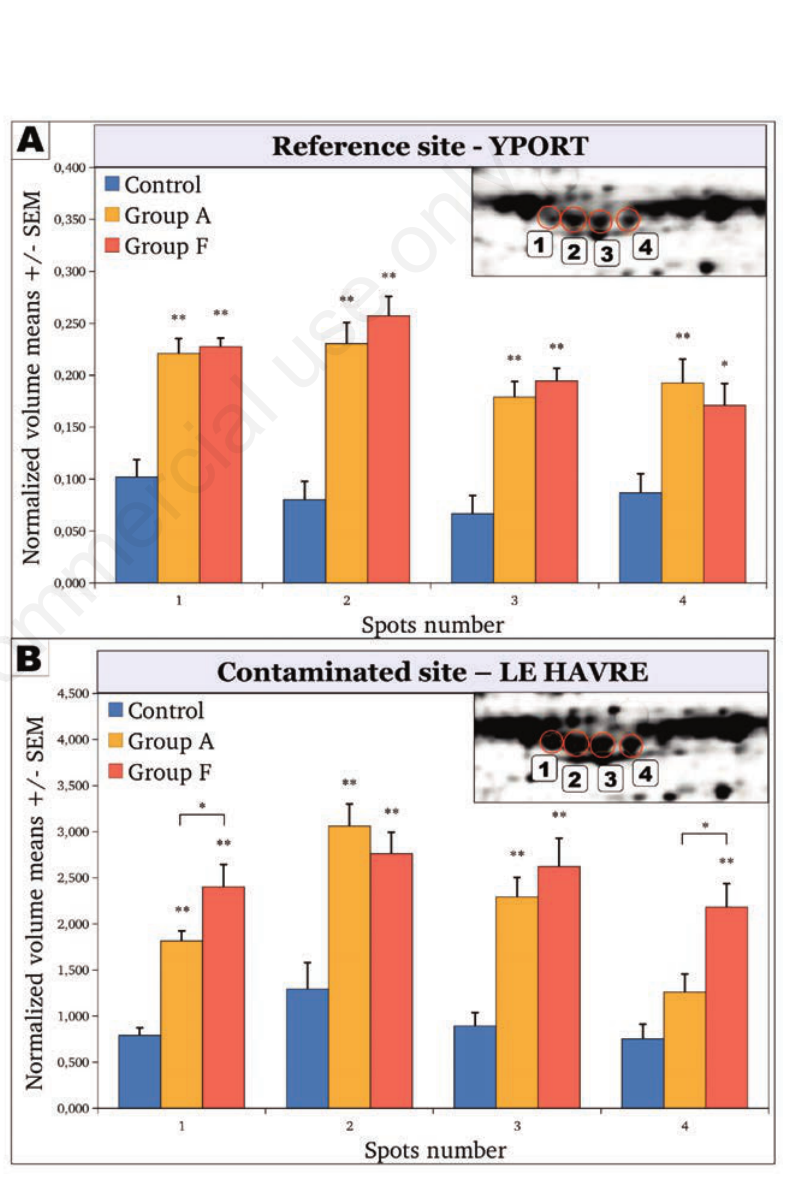
Figure 3. Focus on HSP 70 pattern. Four spots corresponding to HSP 70 proteoforms (upper right corner) were detected and individually compared between three conditions (C: control, A: present thermal conditions and F: predicted future conditions) and two sites: Yport (A) and Le Havre (B). Results are expressed as mean of normalized volumes±SEM, n=8. Differences between conditions were tested using Student t -test (**P<0.01,